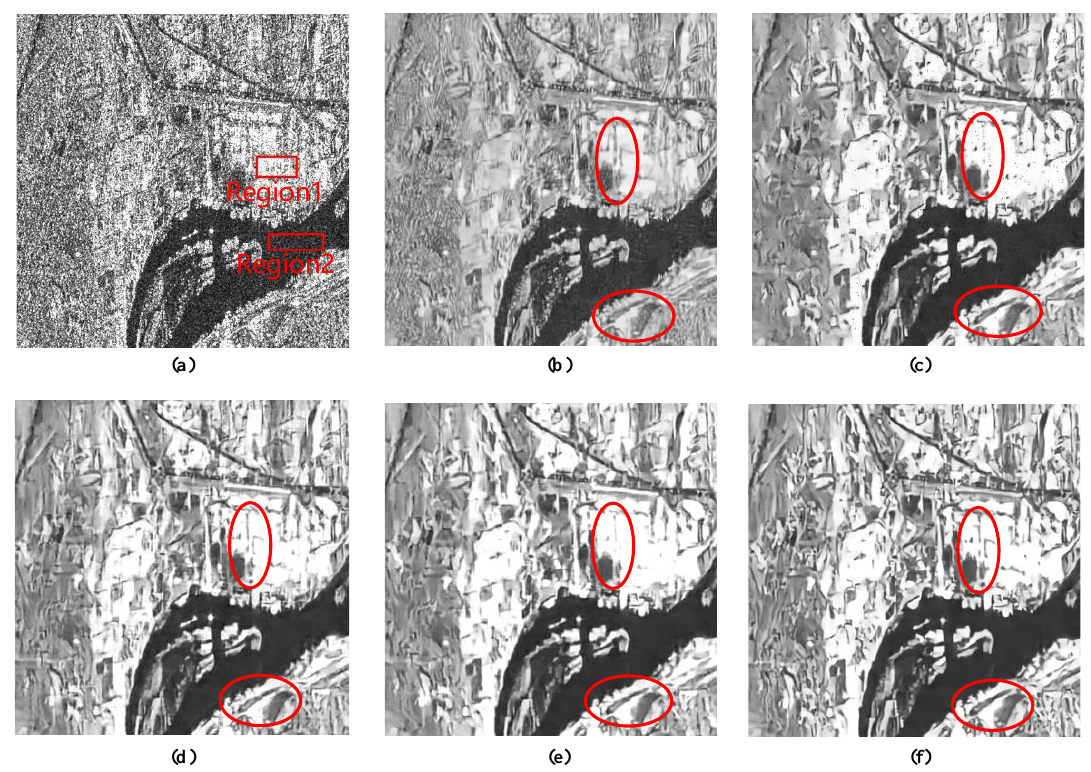
Figure 10. Test results of Real SAR images (RADARSAT-2). ( a ) Original, ( b ) SAR-BM3D, ( c ) ID-CNN, ( d ) RED-Net, ( e ) single scale network (SS-net), ( f )